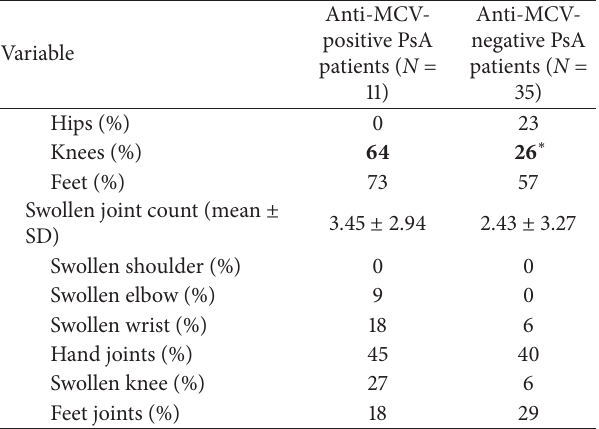
Table 3: Comparisons of clinical findings in anti-MCV-positive and anti-MCV-negative PsA